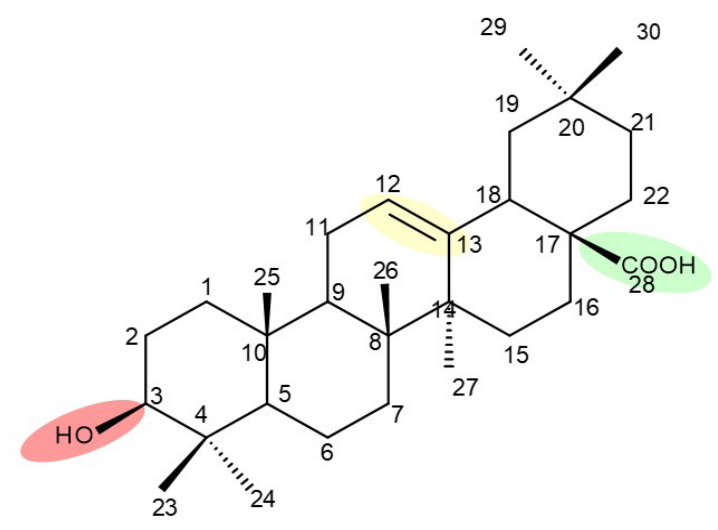
Figure 11. Frequent targets for the derivatization of oleanolic acid.